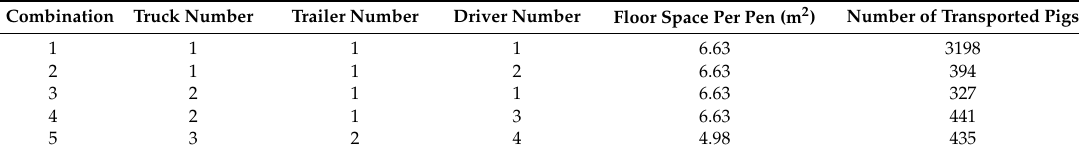
Table 2. Used transport combinations during the monitoring. Per combination truck number, trailer number, driver number, floor space per pen and total number of transported pigs is